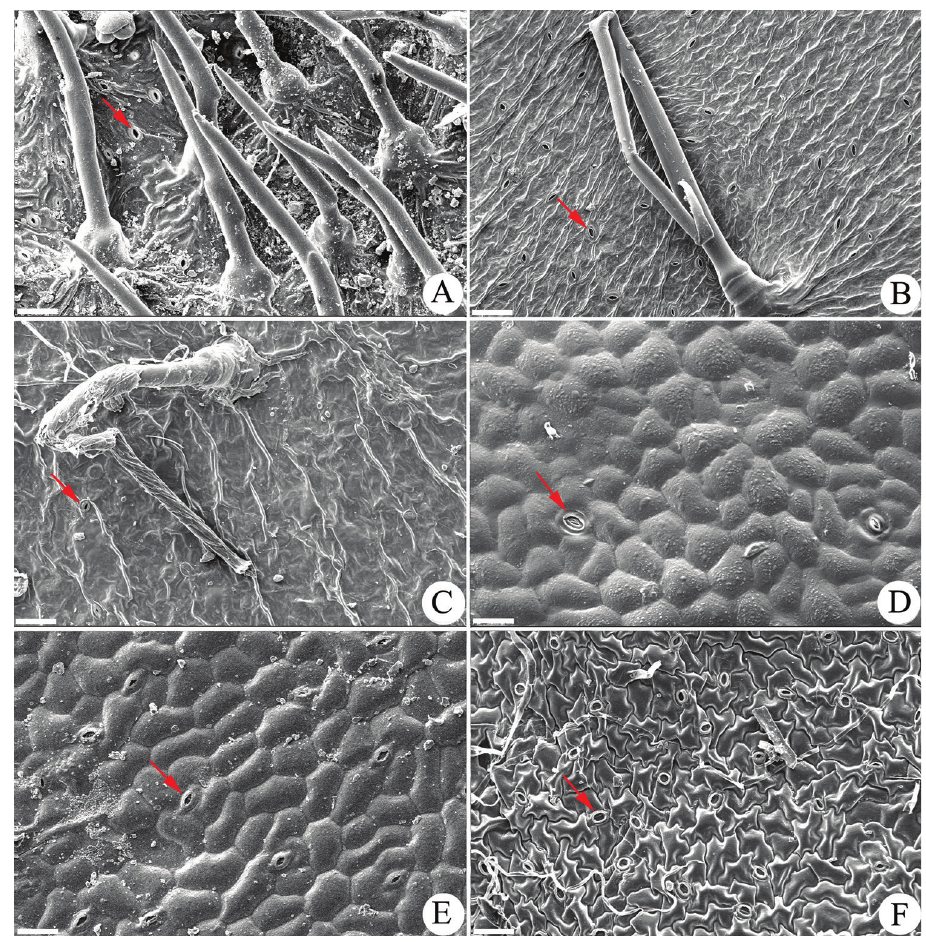
Figure 1. Adaxial leaf epidermal surface morphology of African Gerbera and Asian Leibnitzia . A G. ambigua (sect. Lasiopus ) B G. piloselloides (sect. Piloselloides ) C G. perrieri (sect. Pseudoseris ) D G. serrata (sect. Gerbera ) E G. crocea (sect. Gerbera ) F L. nepalensis. Bar=50